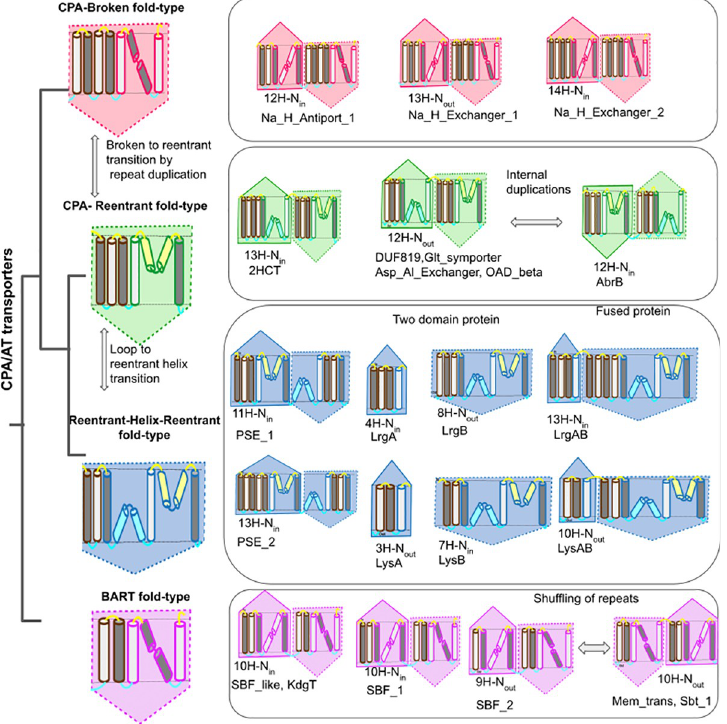
Fig 8. Fold-types and their evolution in CPA/AT transporters. The four fold-types of CPA/AT transporters are shown. Topologies, type of core helix (Broken/reentrant), the orientation of the N-terminal helix as well as other data are listed. All the evolutionary events responsible for the evolution of fold-types are summarized. The TM helices (in- out) and TM helices (out-in) are colored dark grey and white, respectively. Reentrant helices (in-in) and (out-out) are colored yellow and blue